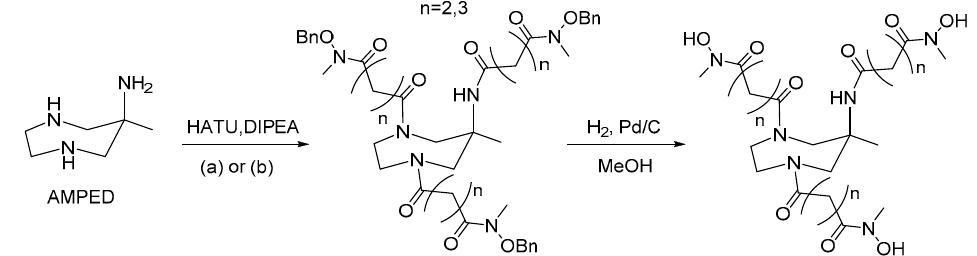
Figure 1. Brief synthesis scheme of AAZTHAS and AAZTHAG chelators. ( a ) 5-((benzyloxy)(me-